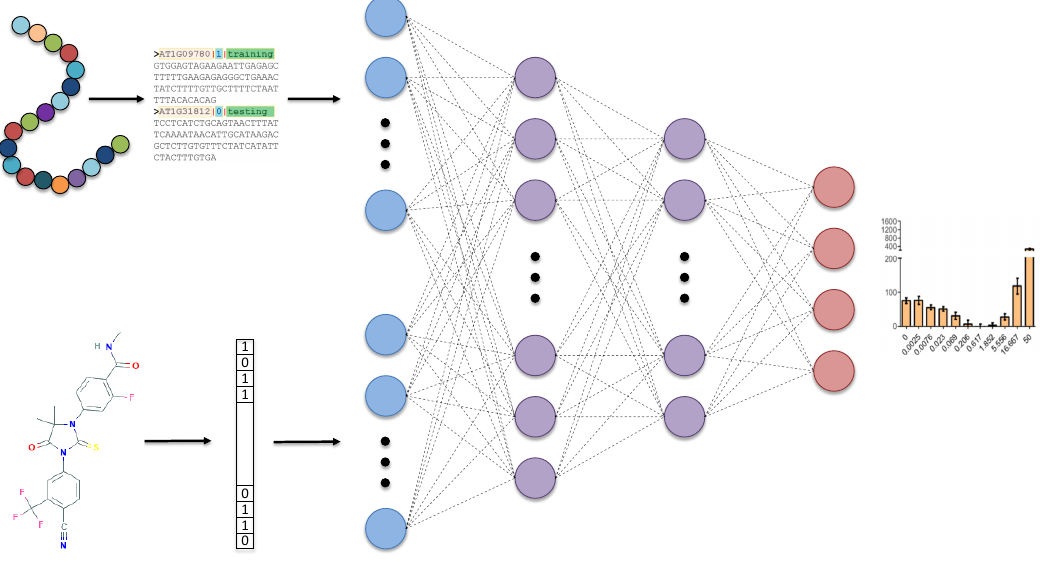
Figure 2. Overview of deep neural network (DNN) model taking sequence and 2D chemical descriptors as input, 2 hidden layers with 128 and 32 nodes, respectively, and a 4 node output to classify four categories of dose response